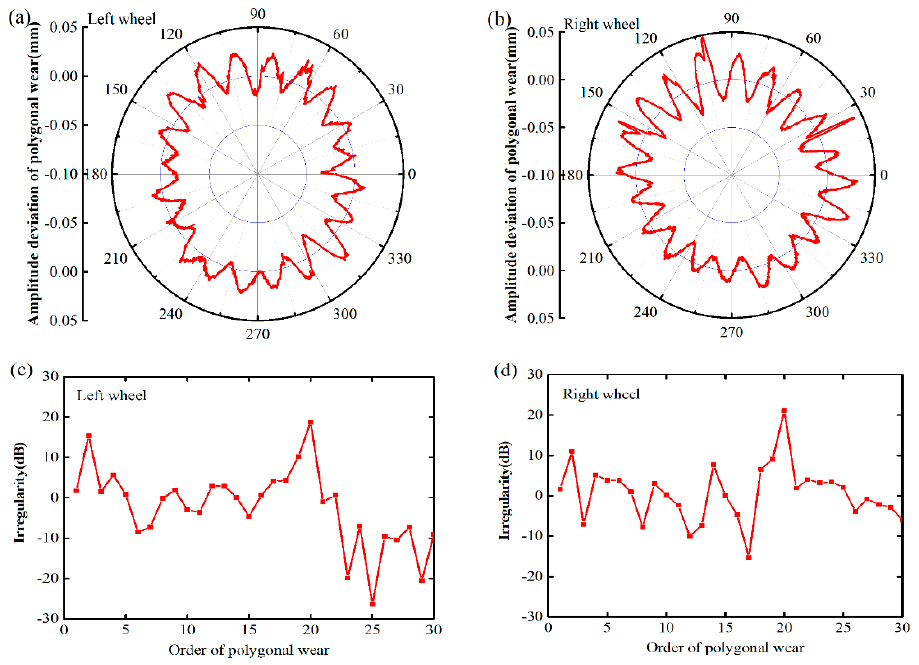
Figure 19. Measured wheel polygonal wear.( a ) left wheel ( b ) right wheel in the polar coordinate system; the irregularity spectrum of ( c ) left wheel ( d ) right wheel.